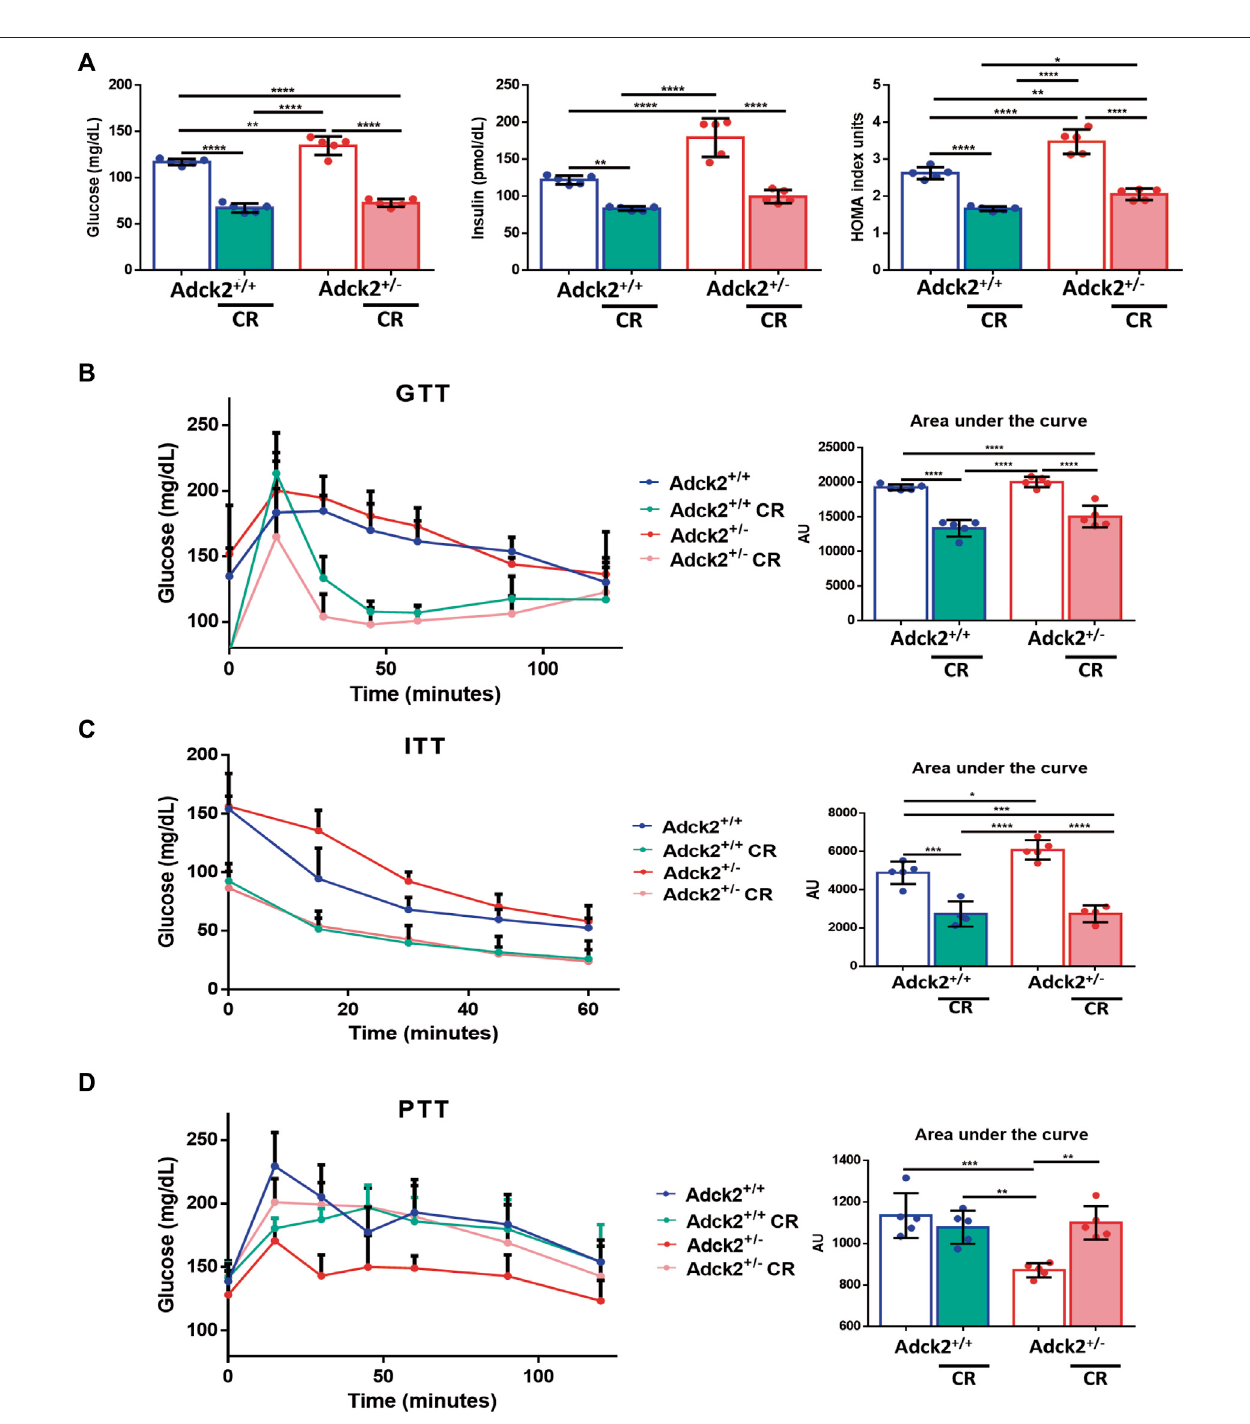
FIGURE 1 | Glucose and insulin homeostasis on calorie restriction conditions. (A) . Fasting glucose and insulin levels in plasma, HOMA index ( N = 5). (B) . Glucose tolerancetest(GTT),glucoseconcentrationinbloodafterglucoseloadandareaunderthecurve(AUC)quanti fi cation(N=5). (C) .Insulintolerancetest(ITT),plasmalevels of glucose after insulin injection and AUC quanti fi cation (N = 5). (D) . Pyruvate tolerance test (PTT). Glucose levels in blood after pyruvate injection and AUC quanti fi cation (N = 5). CR, calorie restriction. Data represent the mean ± SD. One-way ANOVA test was applied. * p < 0.05; ** p < 0.01; *** p < 0.001; **** p < 0.0001.